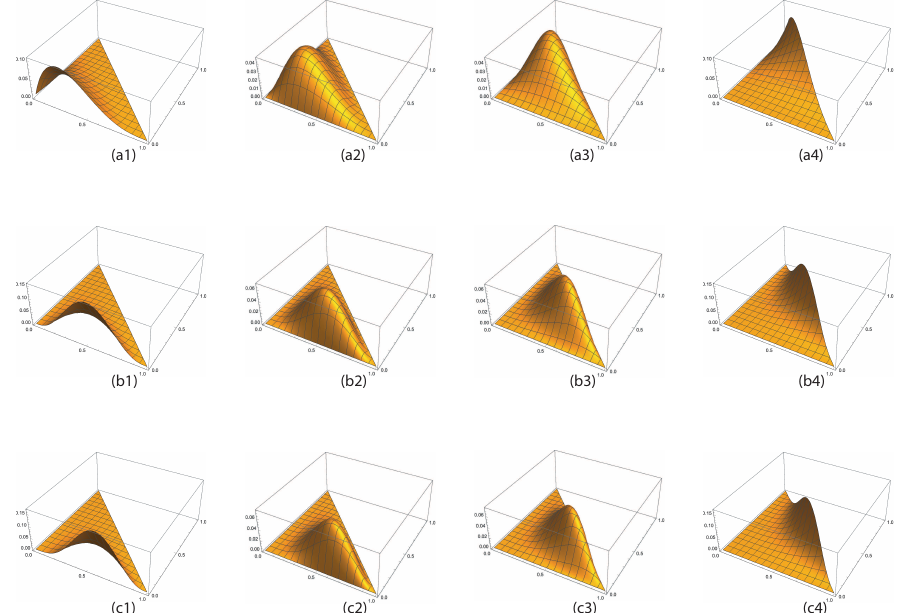
Figure 1: Triangular Meyer-König-Zeller basis functions with n = 0, 2, 3 and k = 3 which are P 0,3,0 ( µ ) (a1), P 0,3,1 ( µ ) (a2), P 0,3,2 ( µ ) (a3), P 0,3,3 ( µ ) (a4), P 2,3,0 ( µ ) (b1), P 2,3,1 ( µ ) (b2), P 2,3,2 ( µ ) (b3), P 2,3,3 ( µ ) (b4), P 3,3,0 ( µ ) (c1), P 3,3,1 ( µ ) (c2), P 3,3,2 ( µ ) (c3), P 3,3,3 ( µ )